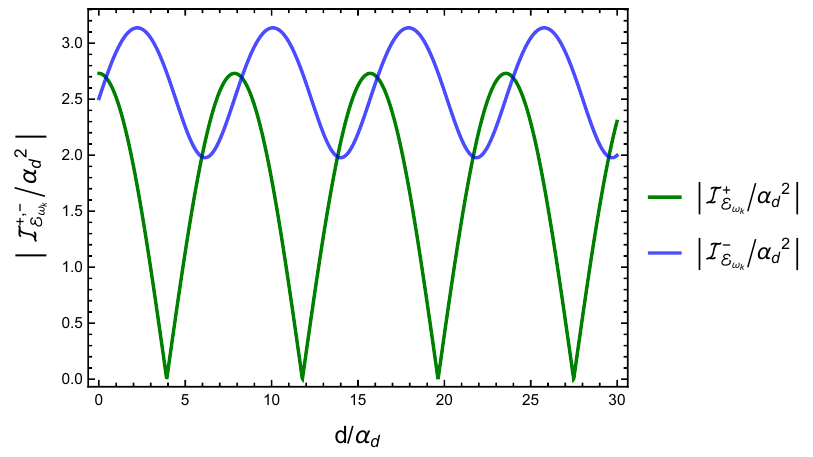
and |I − are plotted in green and blue lines, respectively Figure 28 . The quantities |I + | /r 2 | /r 2 H H E ωk E ωk for two outgoing null detectors in different parallel paths in a (1+1) dimensional de Sitter spacetime with respect to the separation between the two paths d/r . The dimensionless frequency of the H field are fixed at ω = 0 . 4 . The detector transition energy is fixed at ∆ E = 0 . 5 k